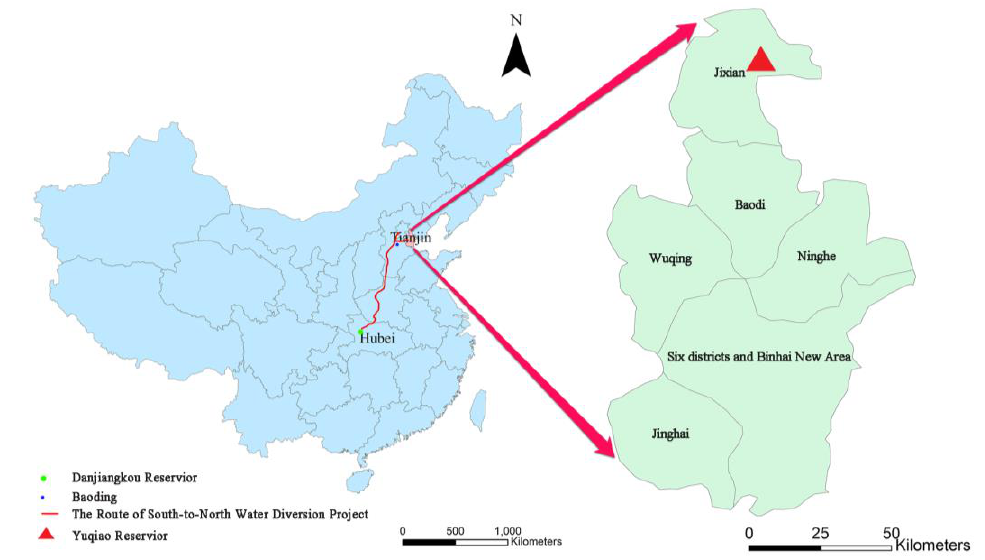
Figure 6. Location of SNWDP, Yuqiao Reservoir, and Tianjin in China.